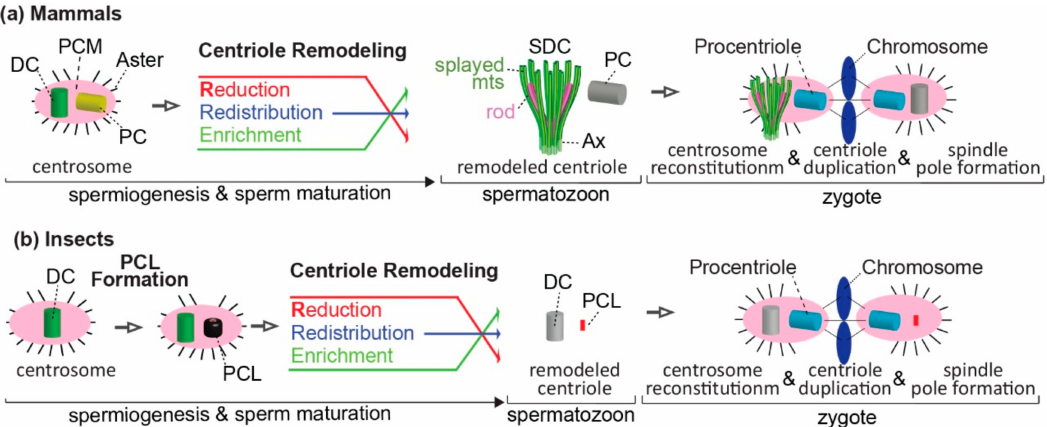
Figure 5. Mechanisms of atypical centriole formation in mammals and insects. ( a ) Model of centriole remodeling that transforms the typical centriole to an atypical centriole, and the role of sperm centrioles in the zygotes of non-rodent mammals. The early spermatid centrosome is made of two typical centrioles (PC and DC) and pericentriolar material (PCM) that form an aster. During spermiogenesis, centrosomal proteins are redistributed, and their amount is altered (reduced or enriched). Consequently, the DC is remodeled and forms an atypical centriole: the spermatozoon distal centriole (SDC). The SDC is made of rods and splayed microtubules (mts), which are attached to the core of the flagellum (axoneme, Ax) in the mature spermatozoon. The PC remains structurally typical, but it has an atypical protein composition. After fertilization, both the typical and atypical centrioles recruit maternal PCM and reconstitute the zygote centrosome. Later, these typical and atypical centrioles separate and each form a centrosome, an aster, a new centriole (procentriole), and a spindle pole at distinct stages of zygote development. ( b ) Model of atypical centriole formation, followed by centriole remodeling, and the role of sperm centrioles in the zygote of insect. The early spermatid centrosome consists of a single centriole that becomes distal centriole (DC). The DC is surrounded by PCM and forms an aster. During early spermiogenesis, an atypical centriole forms: the PCL. During mid and late spermiogenesis, centrosomal proteins are redistributed, and their amount is altered (reduced or enriched). Consequently, the DC protein composition is remodeled, but it maintains a centriole wall made of microtubules, which are attached to the core of the flagellum (axoneme, Ax) in the mature spermatozoon. The PCL is modified structurally and compositionally. After fertilization, both the DC and PCL recruit maternal PCM and reconstitute the zygote centrosome, which later forms an aster, a new centriole (procentriole), and a spindle pole at distinct stages of zygote